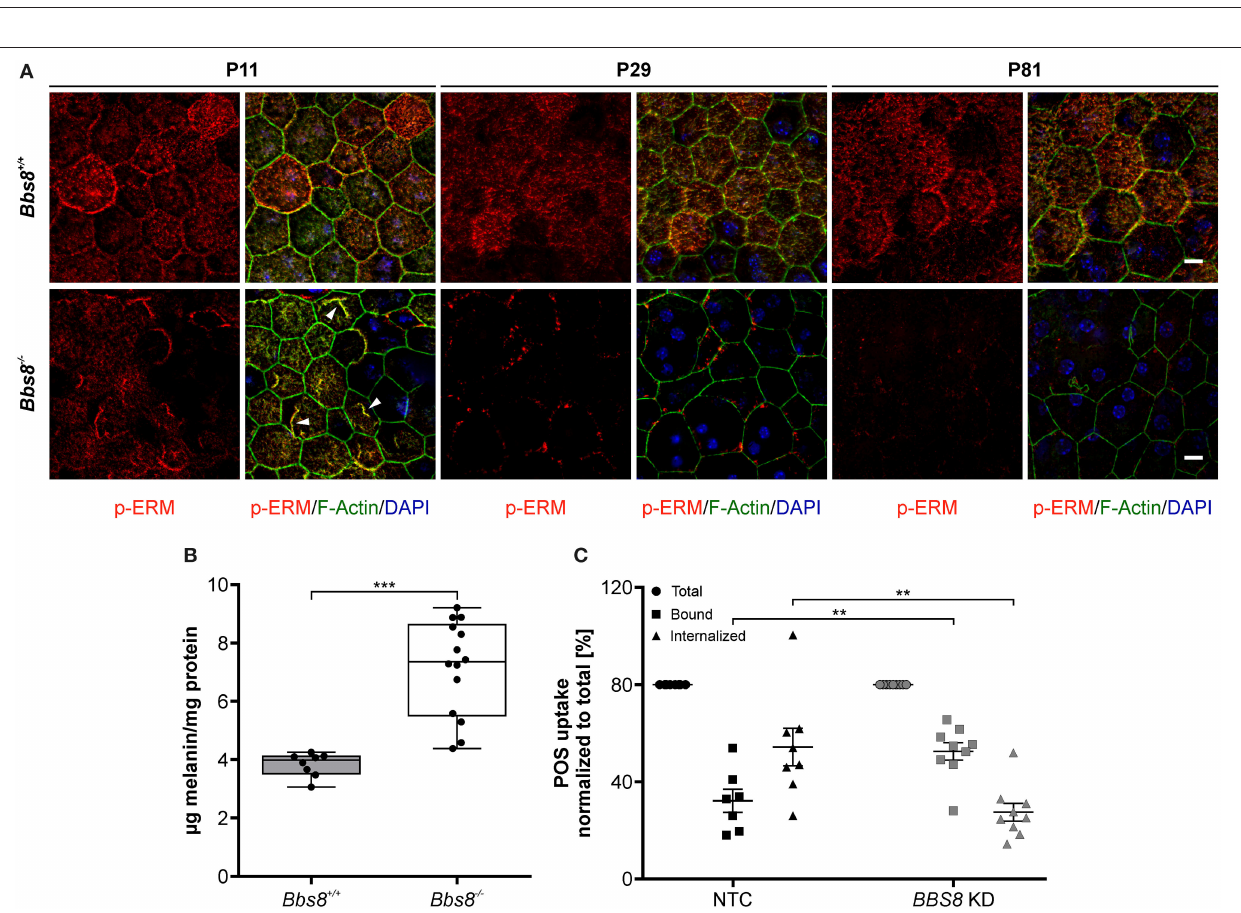
FIGURE 6 | P29 Bbs8 − / − RPE shows larger areas of RPE cells with distorted or even completely disrupted cell membranes (asterisks). Scale bars: 10 µ m. (B–F) Quantification of cell morphology parameters. Statistical analysis is described in methods. (B) Comparison of cell area of Bbs8 − / − and Bbs8 + / + RPE cells reveals an increase of the mean ( p = 6.43 x 10 − 45 ) and the variance ( p = 5.28 x 10 − 52 ) of P29 Bbs8 − / − RPE cells and an increase of variance ( p = 0.0013) of P81 Bbs8 − / − RPE cells. (C) Comparison of cell perimeter of Bbs8 − / − and Bbs8 + / + RPE cells reveals an increase of the mean ( p = 0.0342) and the variance ( p = 0.0272) of P29 Bbs8 − / − RPE cells. (D) Comparison of hexagonality score of Bbs8 − / − and Bbs8 + / + RPE cells. The blue line depicts a trend toward cells being less hexagonal in the mutant over time. The opposite trend (red line) is observed in Bbs8 + / + RPE. (E) The standard deviation of the hexagonality score trends upwards in the mutant (blue line). The opposite trend is observed in Bbs8 + / + RPE (red line). (F) Comparison of polygonality score of Bbs8 − / − and Bbs8 + / + RPE cells reveals a trend to more polygonal cells in Bbs8 − / − RPE with higher age (blue line). The opposite trend is observed in Bbs8 + / + RPE (red line). ( n : P0 Bbs8 + / + = 1,492 cells, P0 Bbs8 − / − = 1,030 cells, P11 Bbs8 + / + = 1,536 cells, P11 Bbs8 − / − = 1,755 cells, P29 Bbs8 + / + = 331 cells, P29 Bbs8 − / − = 383 cells, P81 Bbs8 + / + = 1,128 cells, P81 Bbs8 − / −